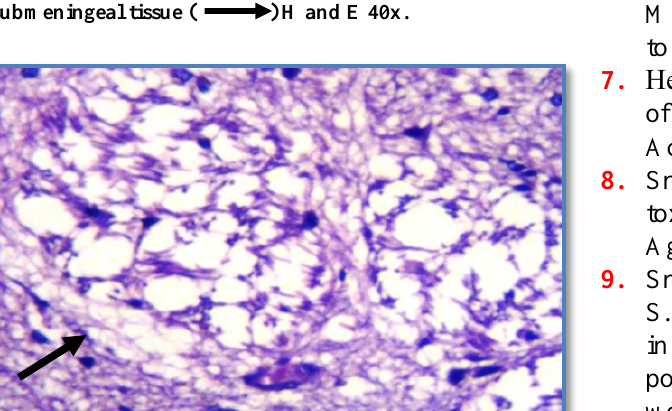
Figure, 5: Histopathological section in the brain (cerebrum) of mice injected I/P with 0.1ml of suspension of digested organs at day 28 showing focal encephalomalacia ( ) H and E 40x.